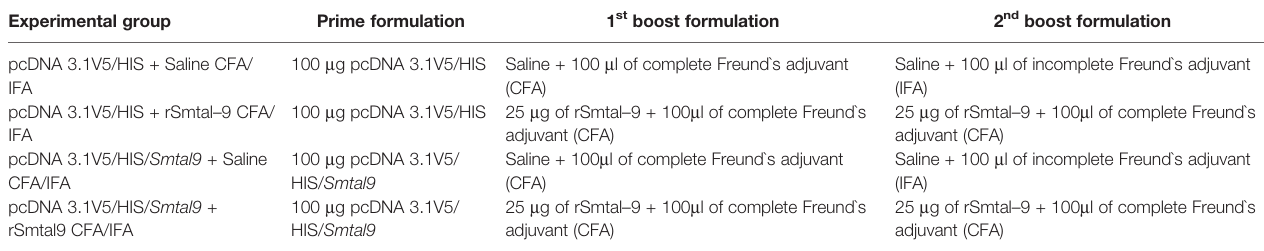
TABLE 1 | Immunization regimen and formulations. Experimental group